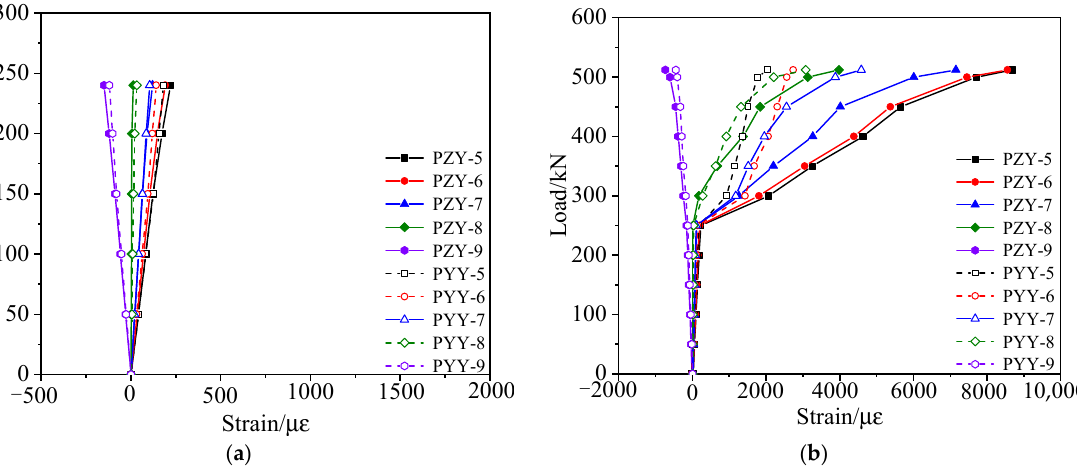
Figure 19. Strain vs. load curve of the concrete web at midspan of the damaged test box girder. ( a ) Working stage with cracks; ( b ) The failure stage.